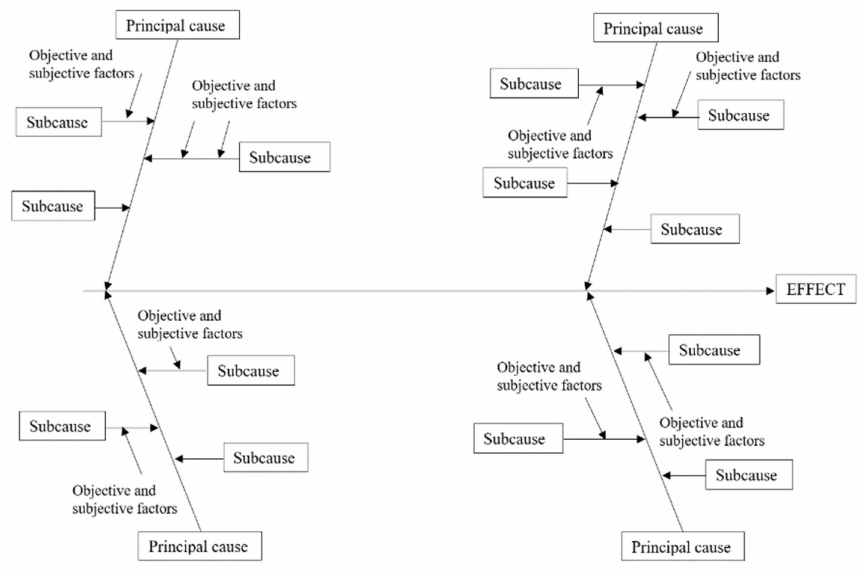
Figure 4. Cause-effect diagram model.